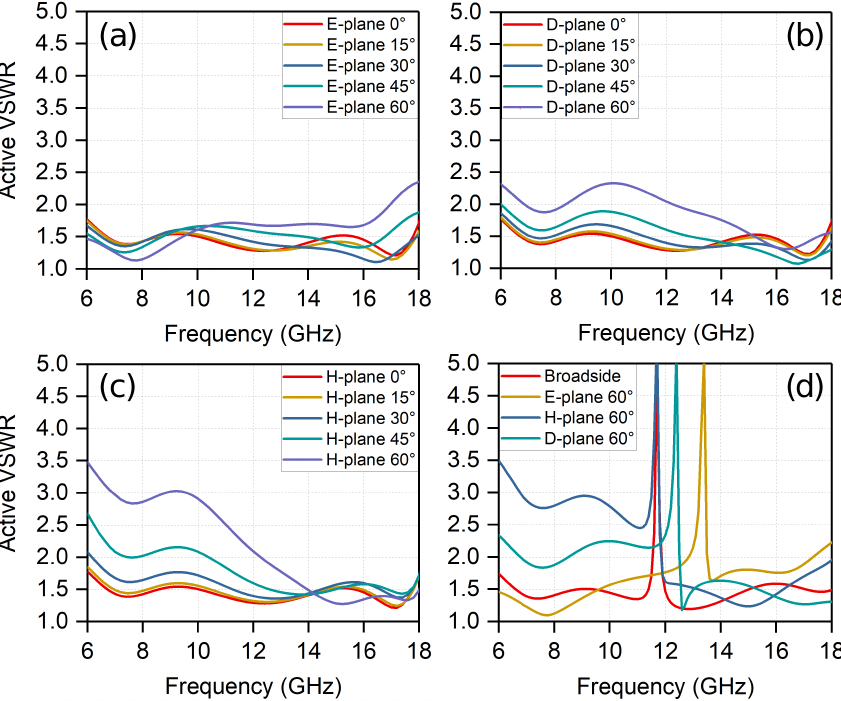
Figure 9. ( a – c ) Simulated active VSWR of proposed array in the E-/H-/D-planes at five different scanning angles; and ( d ) its contrast without plated-through